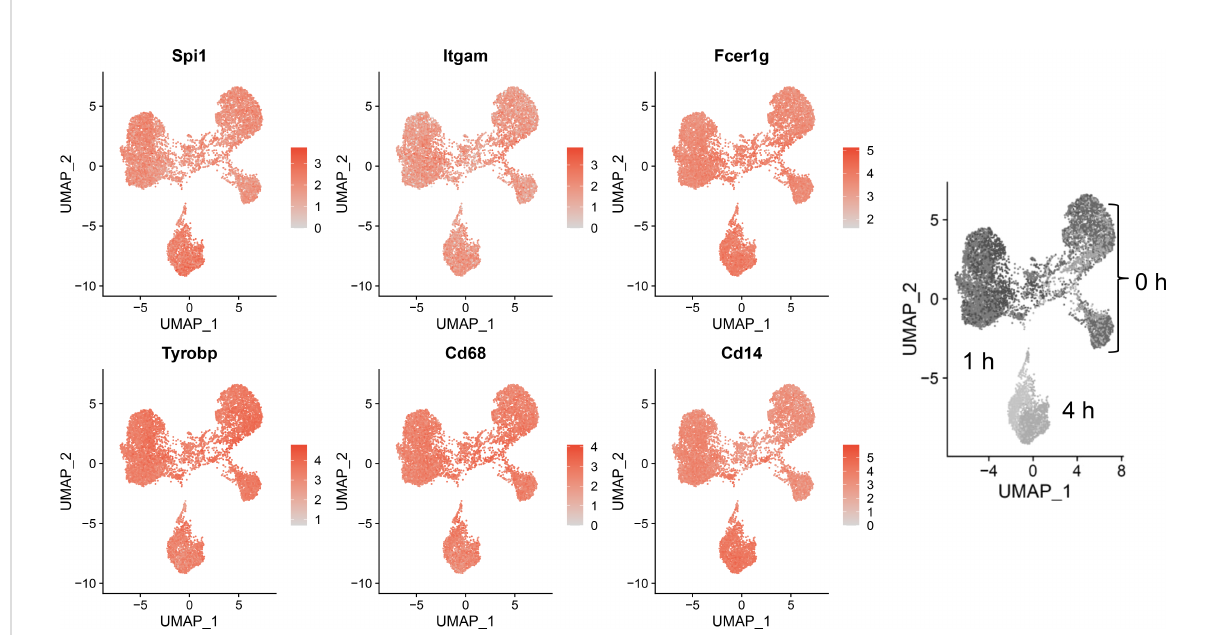
FIGURE 3 Self-renewing FLMs consistently express macrophage-speci fi c genes across all times and treatments. Normalized expression values of individual macrophage-speci fi c genes are overlayed on all cells are plotted using the Seurat FeaturePlot function. Macrophage-identifying genes are present in most cells in all time and treatment clusters indicating robustness of the self-renewing FLM model. Gray-scale image on right derived from (Figure 2A) indicates timepoints represented in